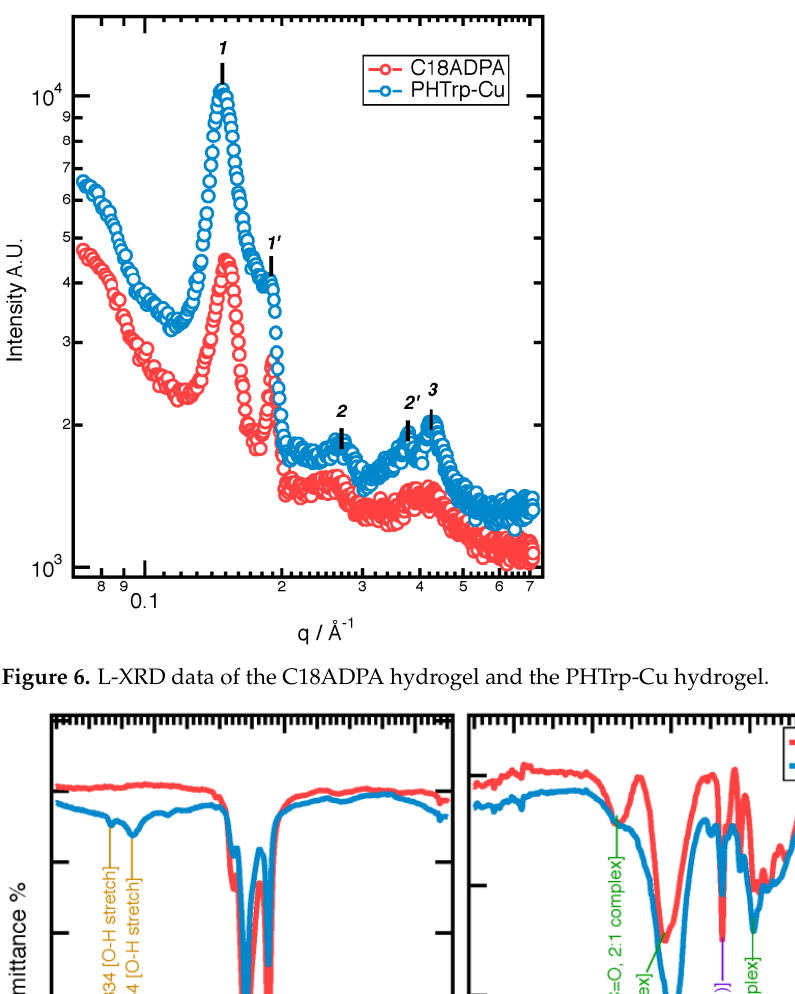
Pharmaceutics 2023 , 15 , 1119